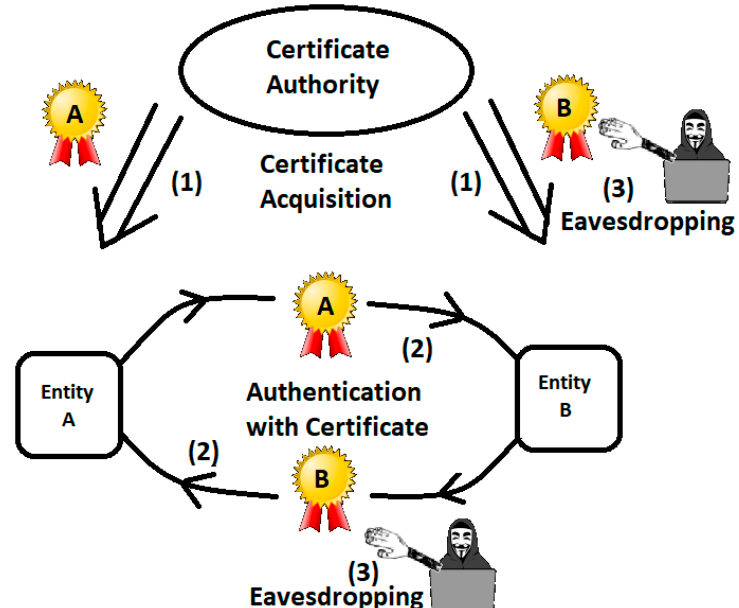
Figure 3. Certificate acquisition ( 1 ), authentication with certificates ( 2 ), and eavesdropping ( 3 ).